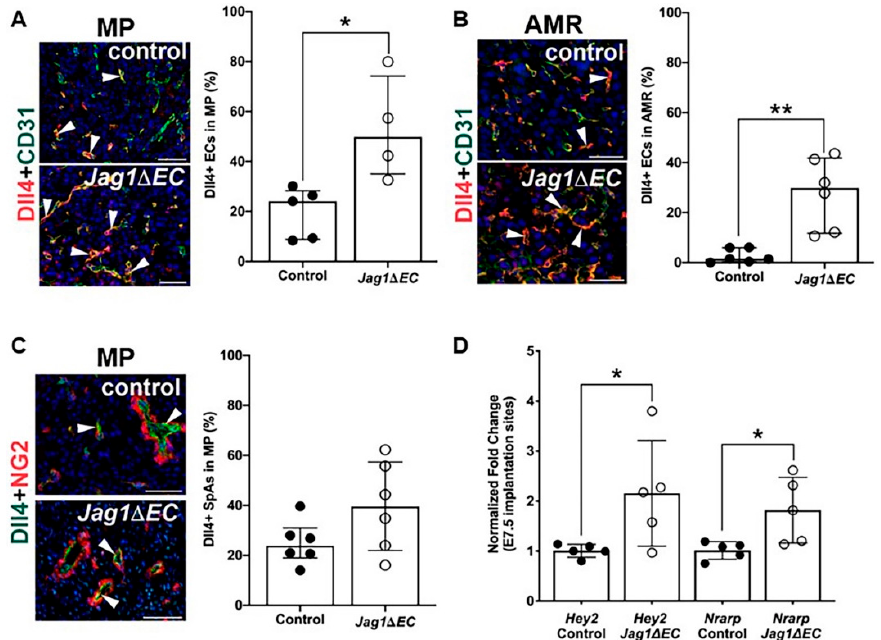
Figure 6. Expression of Notch ligand, Dll4, and Notch effectors are increased in ECs of Jag1 Δ EC decidua. ( A – C ) Expression of Dll4 in capillaries and SpAs in Cdh5-Cre ERT2 control and Jag1 ∆ EC pregnancies was determined by double staining IF for Dll4 and CD31 or NG2. Representative images of the MP ( A ) and AMR ( B ) of control and Jag1 ∆ EC implantation sites. ( A ) Dll4 expression is increased in CD31 + ECs at the MP of Jag1 ∆ EC mutants ( n = 4) as compared to Cdh5-Cre ERT2 controls ( n = 5). ( B ) Dll4 expression is increased in CD31 + capillary ECs in the AMR of Jag1 Δ EC mutants ( n = 6) as compared to Cdh5-Cre ERT2 controls ( n = 6). ( C ) Representative images of the MP of control and Jag1 Δ EC implantation sites double stained for Dll4 and NG2. Expression of Dll4 in the ECs of the NG2 + surrounded SpAs is unchanged in Jag1 Δ EC mutants ( n = 6) as compared to Cdh5-Cre ERT2 controls ( n =